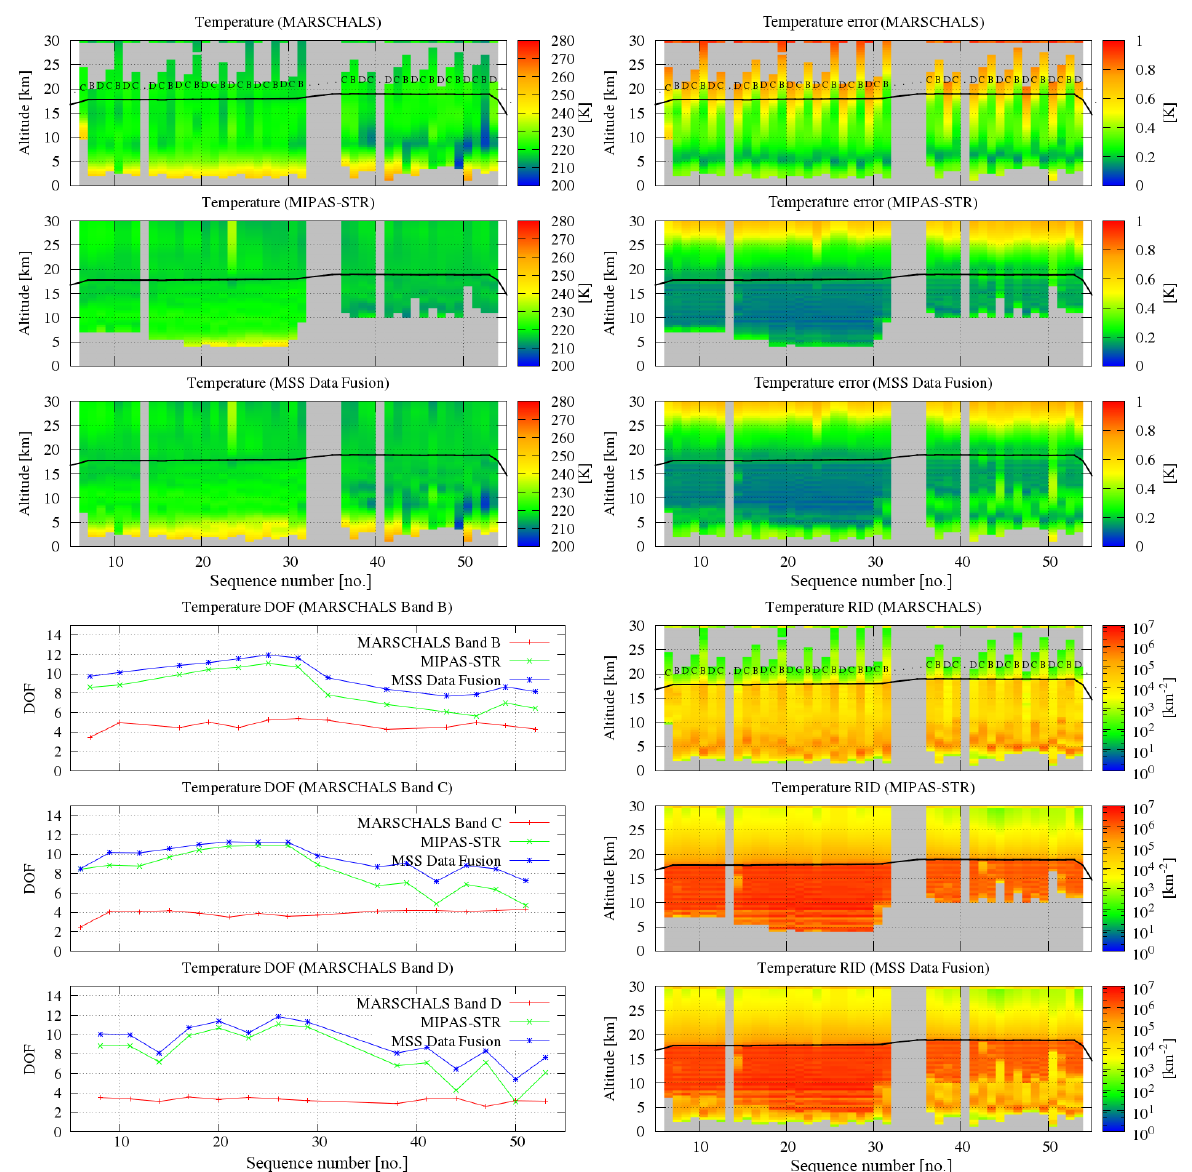
Figure 8. Temperature retrieved results obtained from MSS individual analysis and MSS data fusion of MARSCHALS and MIPAS-STR limb sounding observations: vertical profiles (top left panel), total error profiles (top right panel), number of DOF (bottom left panel) and RID profiles (bottom right